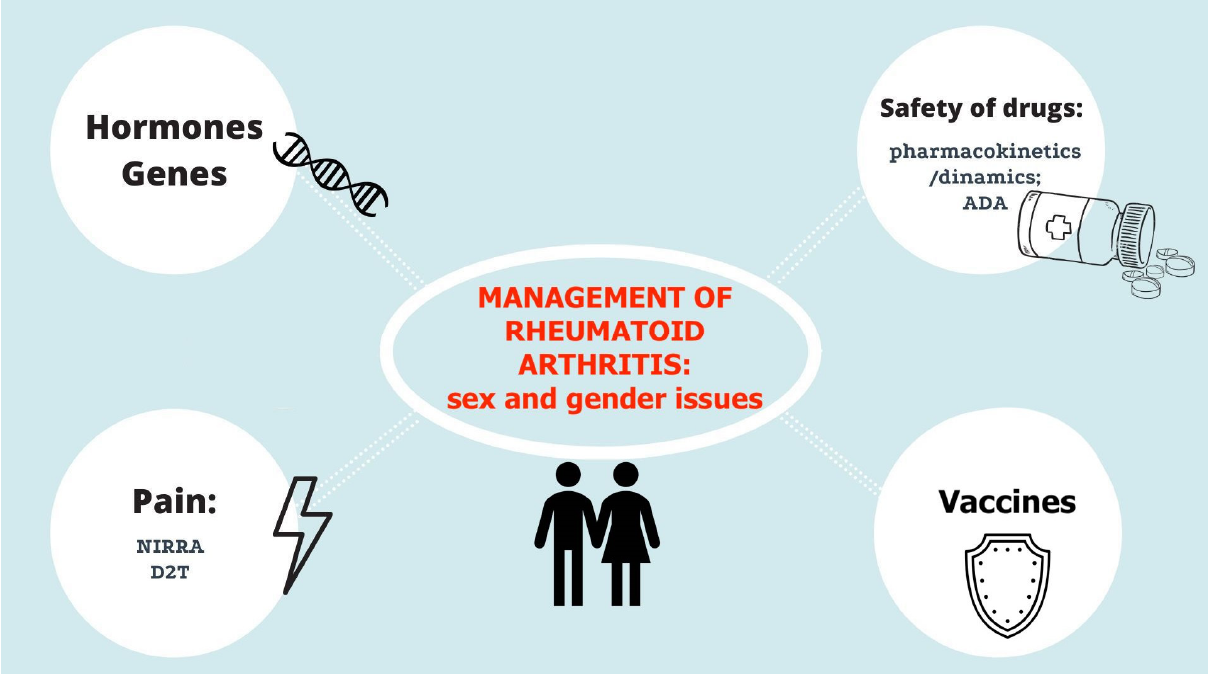
Figure 1. Overview of key principles of RA management from the latest sets of recommendations: both sex- and gender-based factors contribute to the illustrated aspects, affecting clinical response and outcome between females and males and, therefore, should be considered in biomedical research. Abbreviations: ADA = anti-drug antibody ; D2T = difficult-to-treat ; NIRRA = non-inflammatory refractory RA ; T2T = treat-to-target.